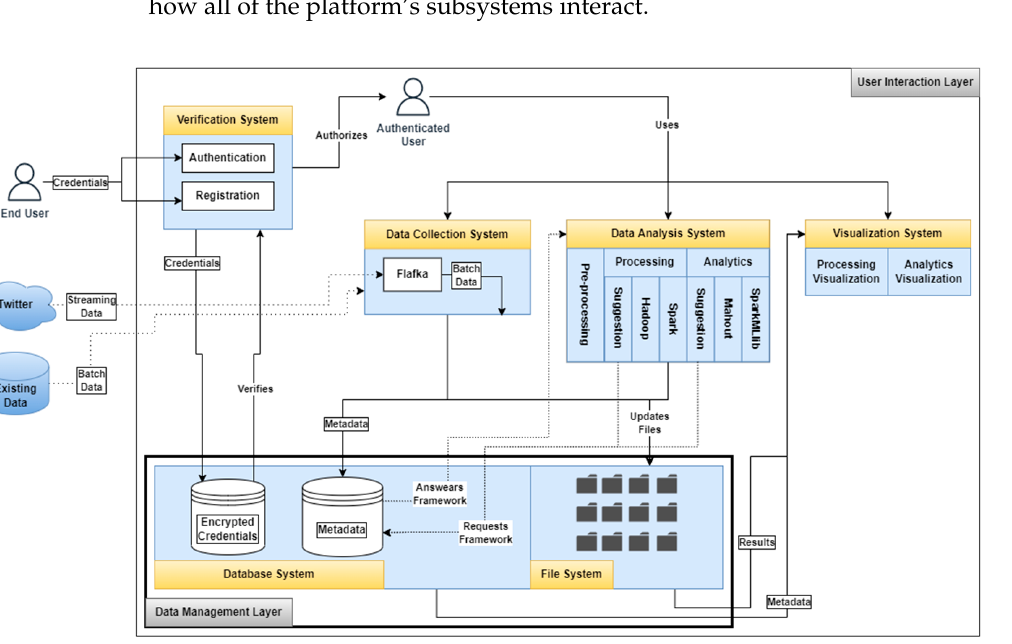
Figure 3. EverAnalyzer Low Level Architecture.